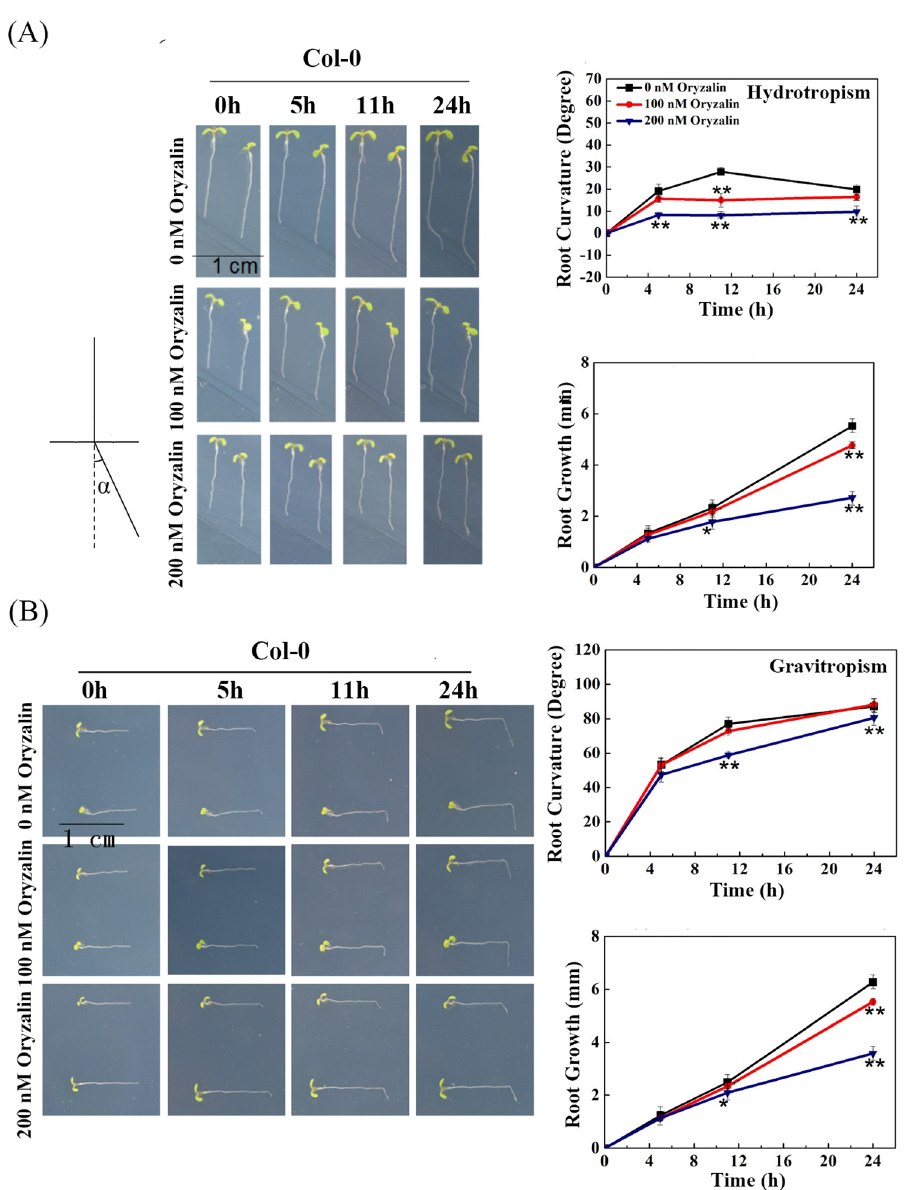
Figure 1. Oryzalin treatments decreased the root hydrotropic response of wild–type (WT) ecotype Col-0. ( A ) Root hydrotropic response and growth of ecotype WT in the absence or presence of 100 nM or 200 nM oryzalin (microtubule destabilizer: microtubule–disrupting chemical). Schematic representation of the root curvature angle ( α ) in the hydrotropism assay was indicated. ( B ) Root gravitropic response and growth of ecotype WT roots in the absence or presence of 100 nM or 200 nM oryzalin. Error bars indicate the SE; n ≥ 36. Asterisk indicates significant difference from the WT at * p < 0.05 or ** p < 0.01 (Student’s t -test).